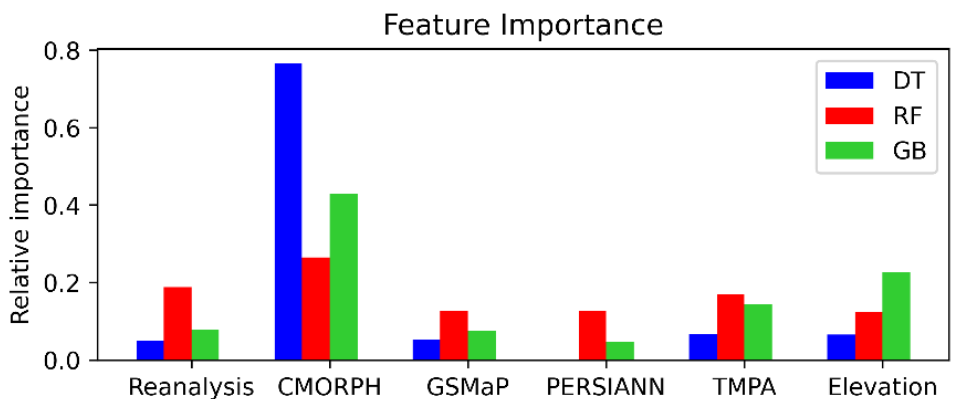
Figure 7. Relative importance of the input features for different algorithms.